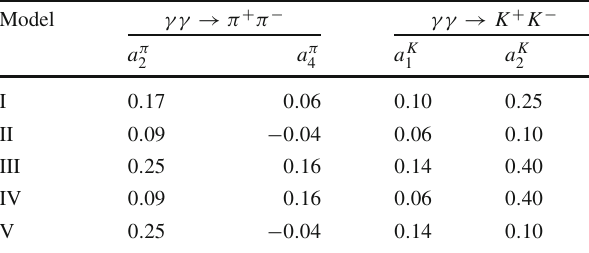
Table 2 Gegenbauer moments of five sample models of the pion and kaon distribution amplitudes at the scale μ 0 = 1 GeV Model γγ → π + π − γγ → K + K